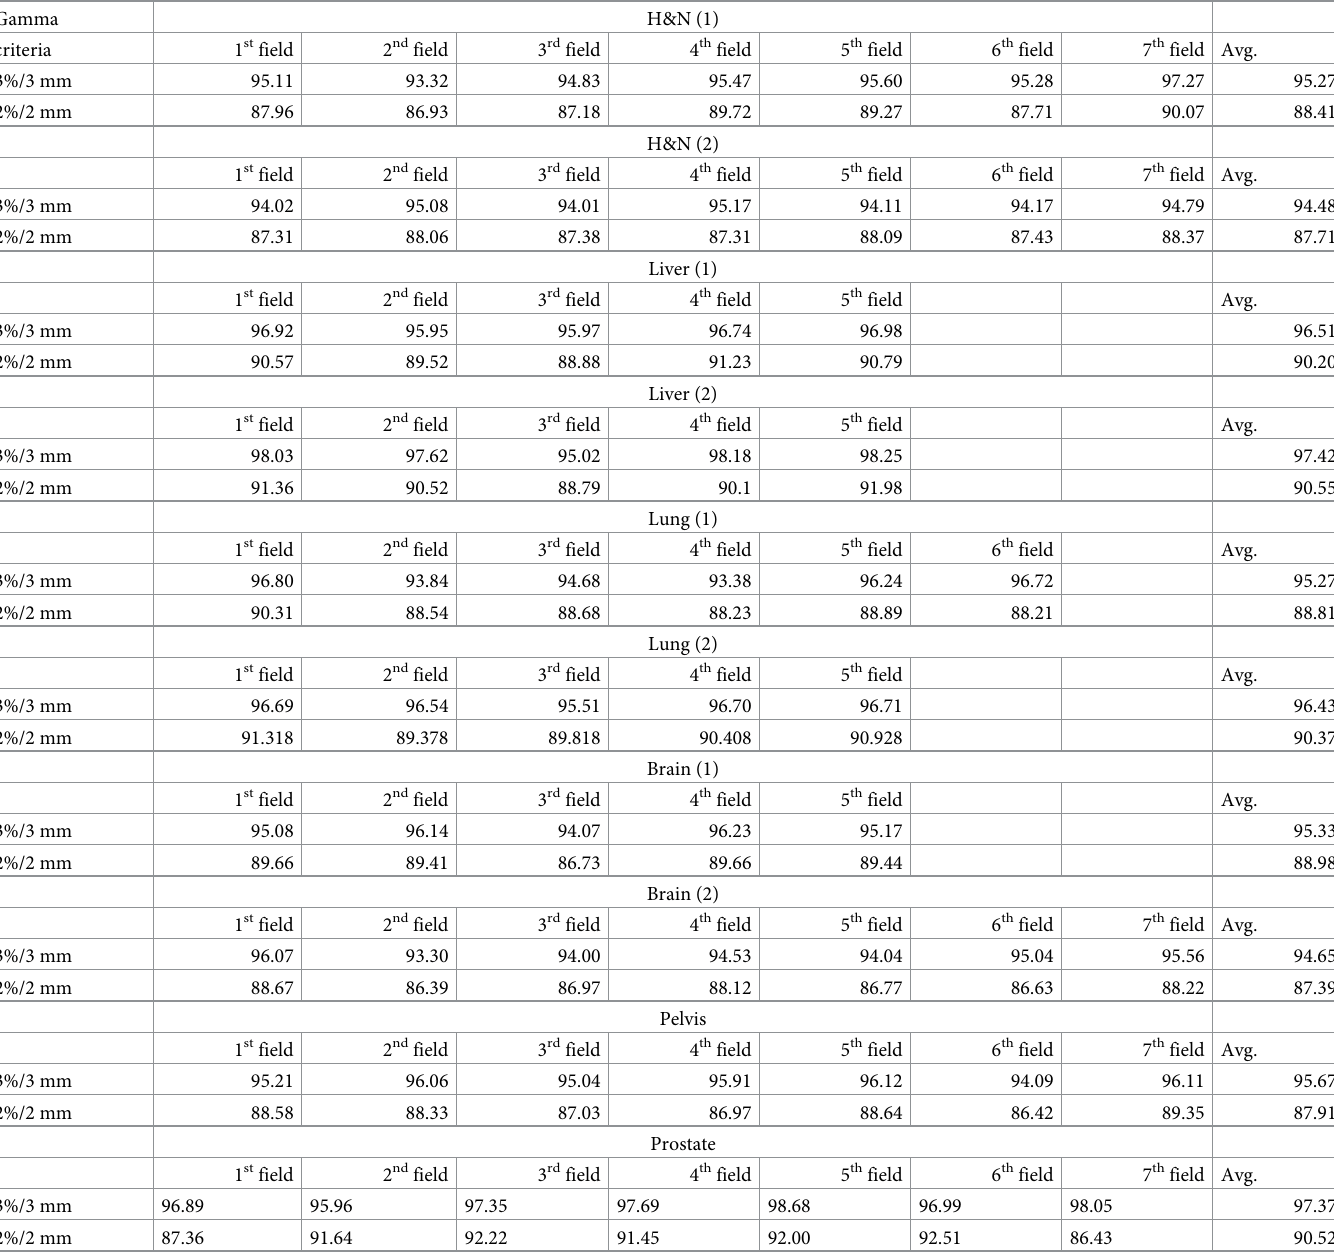
Table 4. Quantitative results of the gamma passing rate per field dose distribution with 2%/2 mm and 3%/3 mm gamma criteria for the 10 IMRT cases (Unit: %). Gamma H&N (1)